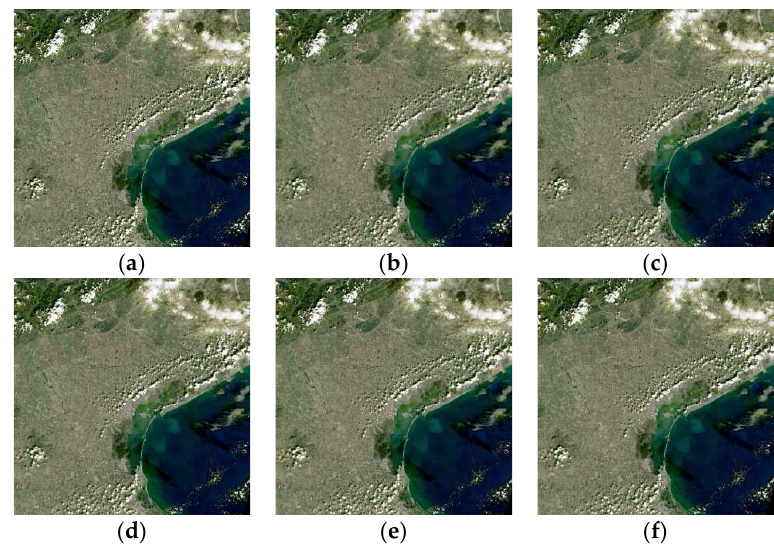
Figure 5. Source image and reconstructed images. ( a ) Source image; ( b ) reconstructed using MFTR; ( c ) reconstructed image (T = 6); ( d ) reconstructed image (T = 6); ( e ) reconstructed image (T = 20); ( f ) reconstructed image (T = 30).